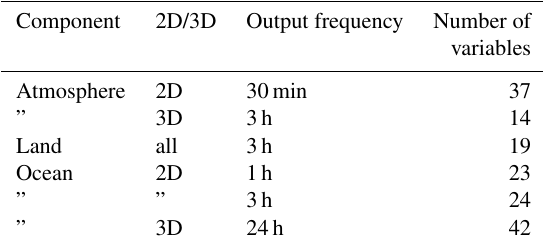
Table 2. Overview of the output of the simulation with a grid spac- ing of 5km, called G_AO_5km in Table